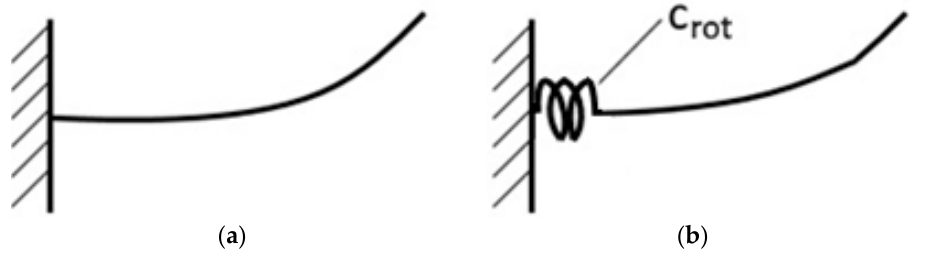
Figure 3. Type of Timoshenko beam connection to the ground: ( a ) fixed; and ( b ) through elastic spring with rotational stiffness C rot .